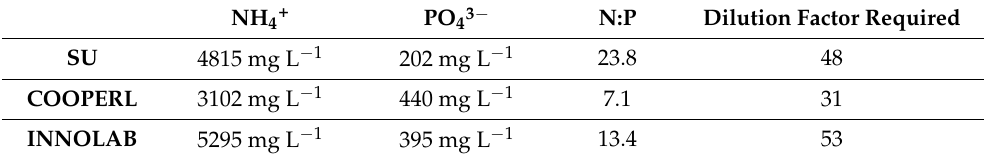
Table 1. Ammonium and phosphorus composition of the three digestates used in the